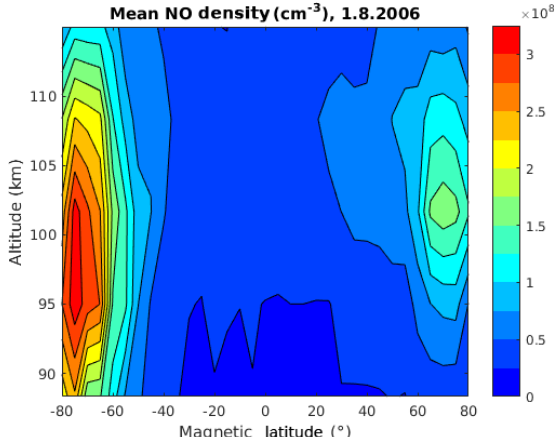
Figure 1. Mean NO density in molecules per cubic centimeter for 1 August 2006 calculated from V3.0 Level 2 Odin SMR data.